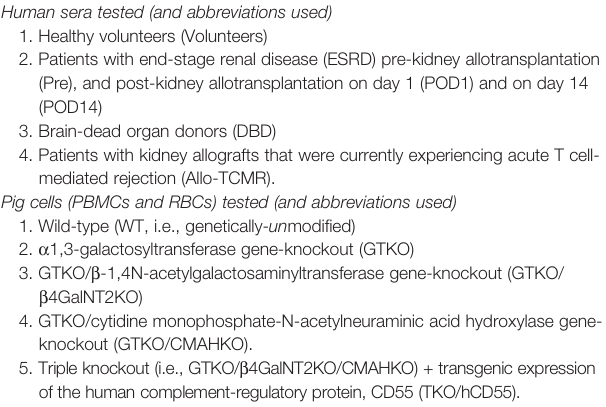
TABLE 1 | Sources of human sera and types of pig cells used in these studies. Human sera tested (and abbreviations used) 1. Healthy volunteers